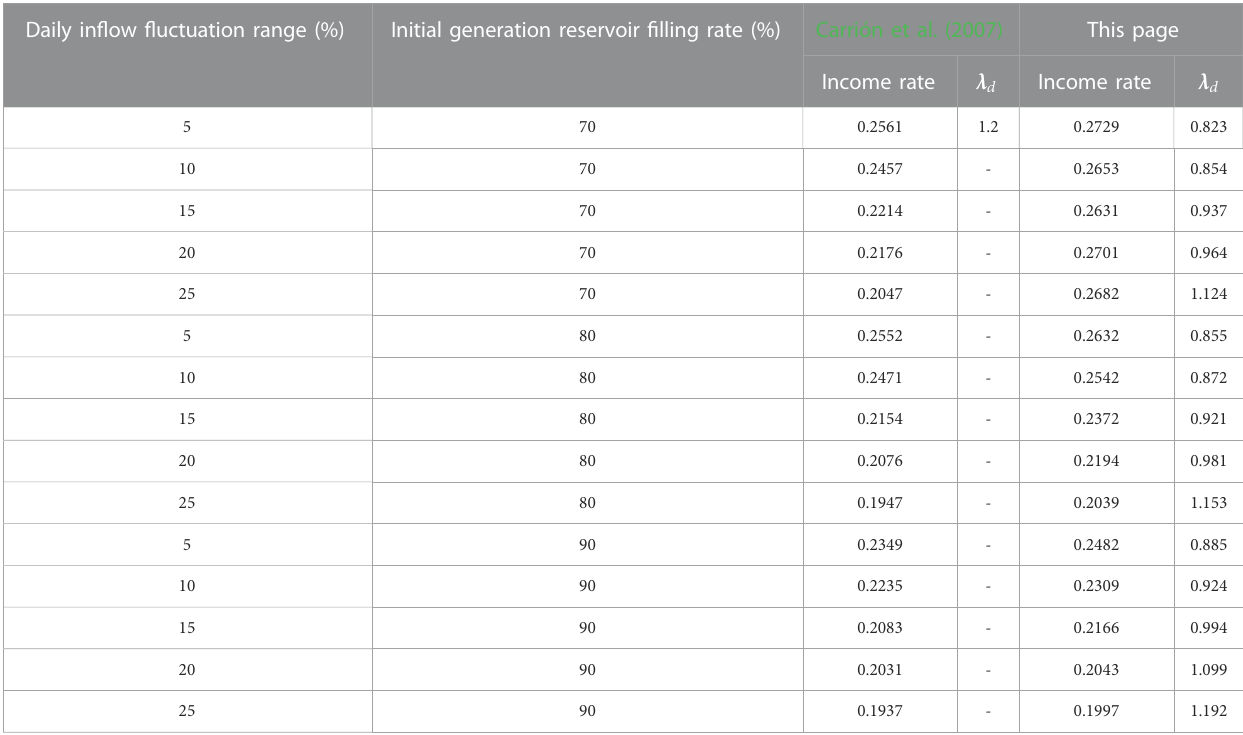
TABLE 5 Performance comparison of portfolio